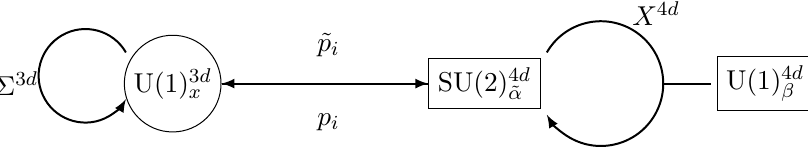
Figure 2 . Quiver depiction of the 3 d (cid:0) 4 d system for the case of the \one bulk | one boundary" Liouville two point function. X 4 d is a 4 d half-hyper, not a full hyper, so we depict it with an arrow. where F ( x (cid:6) y ) = F ( x + y ) F ( x (cid:0) y ) and we rede(cid:12)ned ~ (cid:11) = (cid:0) Q= 2 + (cid:11) , ~ (cid:12) = (cid:0) Q= 2 + (cid:12) . We applied the de(cid:12)nition of S ( x b